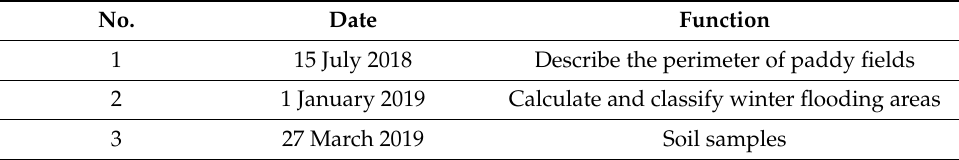
Table 1. Sentinel-2 images used for paddy fields and winter flooding